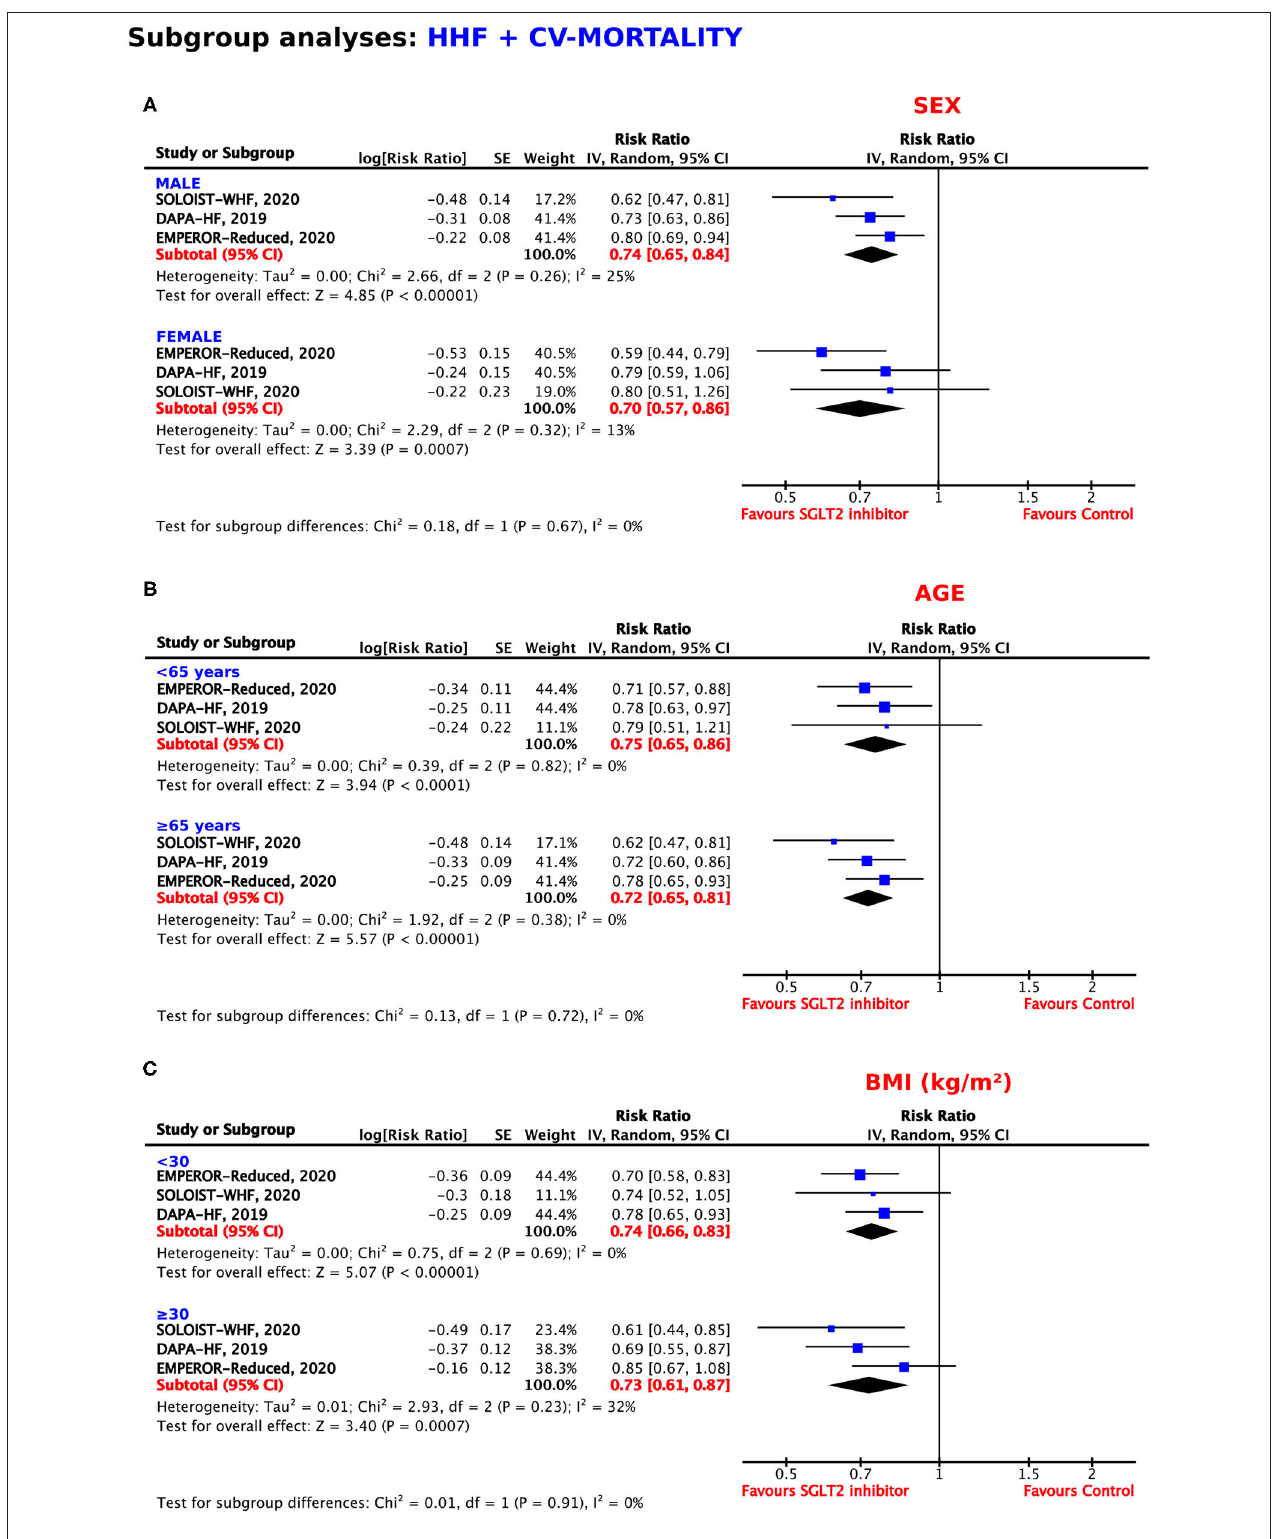
FIGURE 5 | Subgroup analyses for the composite outcome according to (A) sex, (B) age, and (C) body mass index.